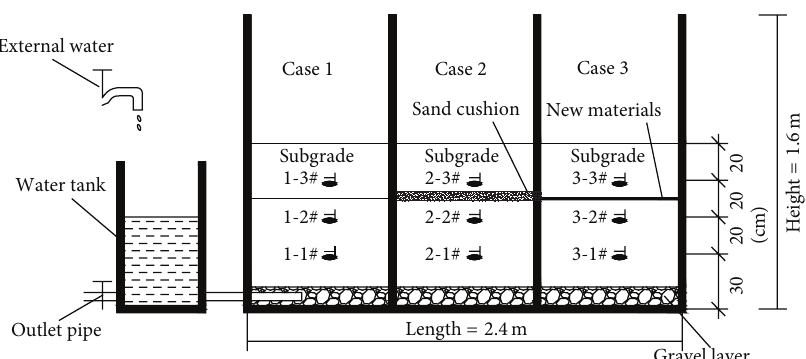
Figure 9: Schematic cross-section of subgrade model.